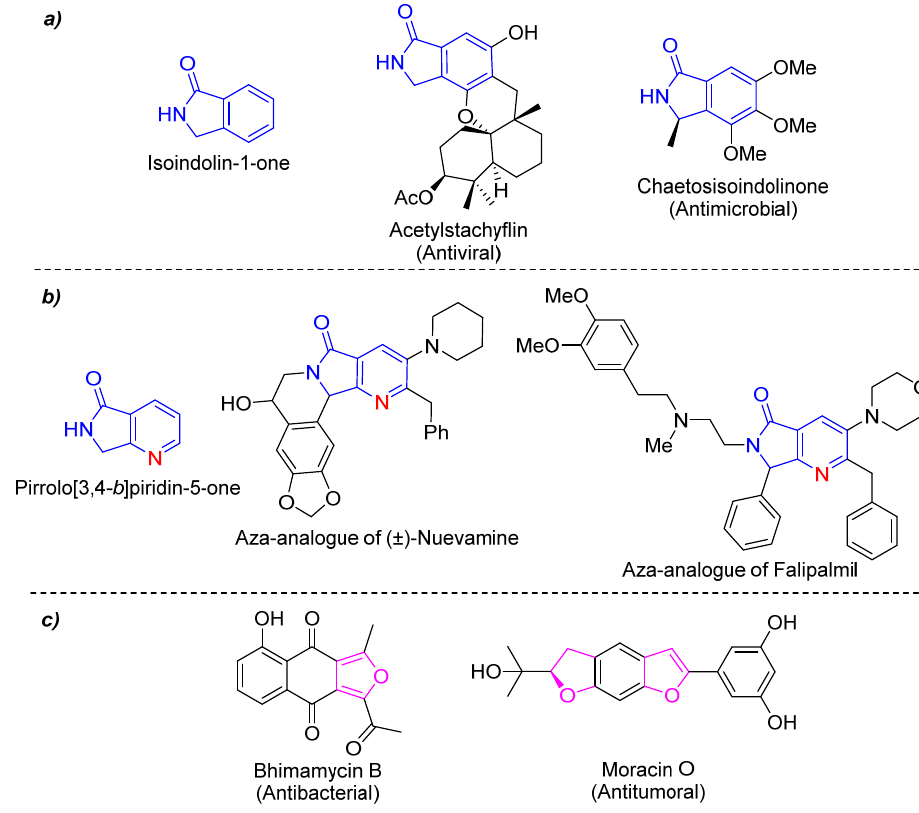
Figure 1. ( a ) Isoindolin-1-one and related natural products, ( b ) Pyrrolo[3,4- b ]pyridin-5-ones and re- lated bioactive compounds, and ( c ) Furan-based drugs. related bioactive compounds, and ( c ) Furan-based